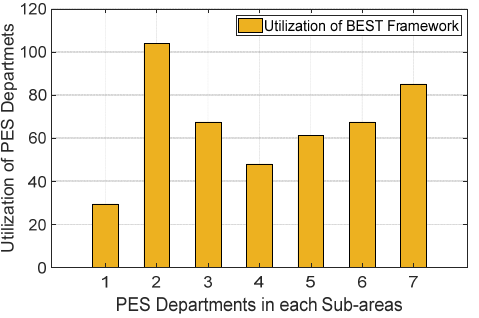
Figure 11. Evaluation of the utilisation of PES departments.